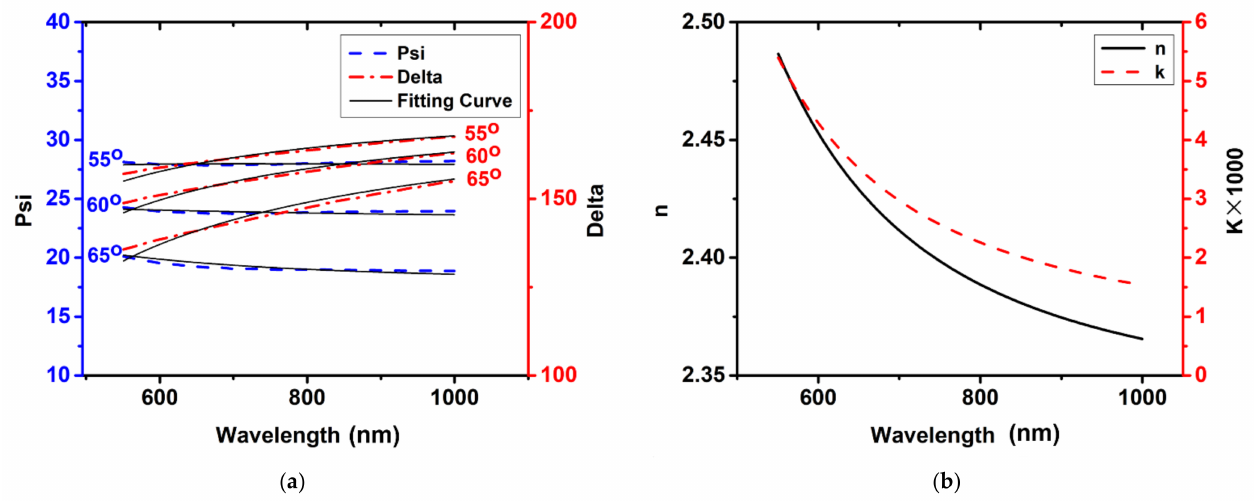
Figure 9. ( a ) Fitting of ellipsometry results Ψ and ∆ for 3 measuring angles, ( b ) optical constants for TiO 2 layer used for